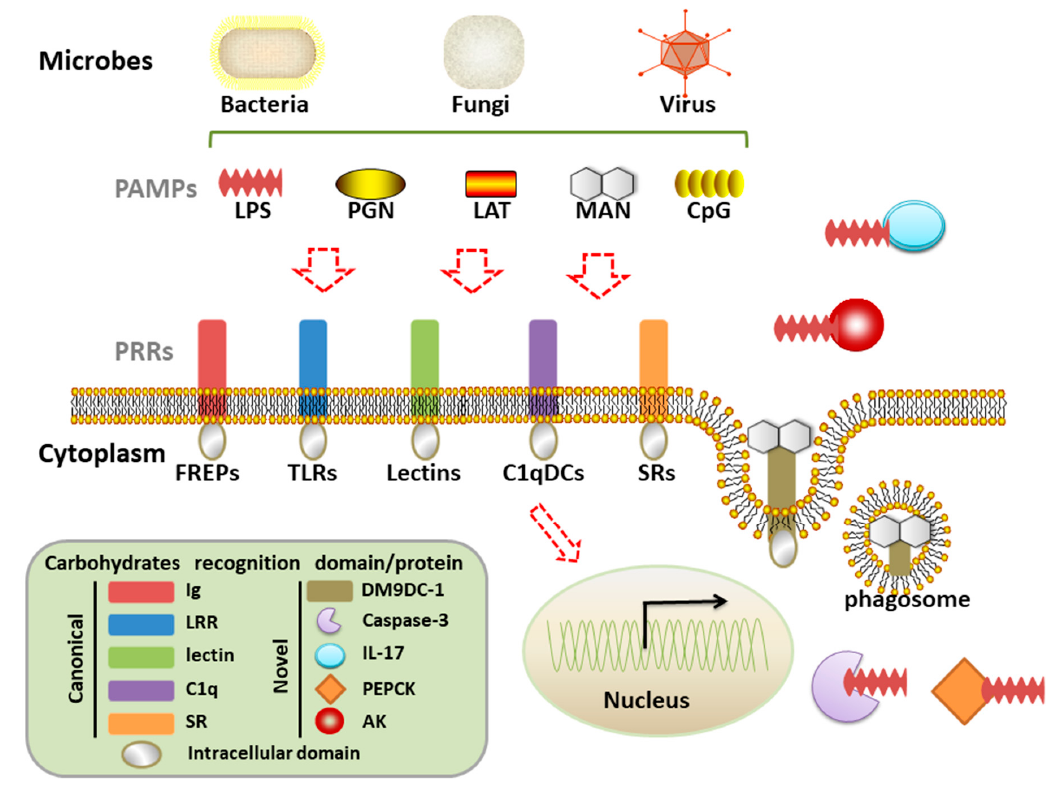
Figure 1. Canonical and novel carbohydrate recognition proteins functioning in molluscan immune defense system. The canonical pattern recognition receptors (PRRs) are mainly composed of five dominant recognition domains, e.g., Ig domain, leucine-rich repeat (LRR) domain, lectin domain, C1q domain, and scavenger receptor (SR) domain. By recognizing (red dotted arrows) the conserved pathogen-associated molecular patterns (PAMPs) of bacteria, fungi and viruses, these PRRs could activate cellular or humoral immune defense and protect host from infection. Except for the canonical PRRs, some new proteins were identified with pathogen derived carbohydrate recognition activity in molluscs, including novel DM9 domain containing protein 1 (DM9DC-1) and some other well-known proteins whose PRR function was discovered recently. (Lipopolysaccharide, LPS; Peptidoglycan, PGN; Lipoteichoic acids, LTA; Mannan, MAN; Fibrinogen-related proteins, FREPs; Toll like receptors, TLRs; C1q domain containing proteins, C1qDCs; Scavenger receptors, SRs; Phosphoenolpyruvate carboxykinase, PEPCK; Arginine kinase, AK; black arrow, gene expression).